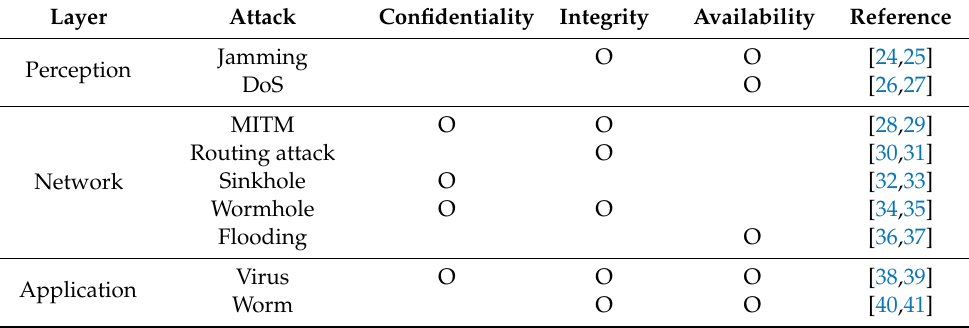
Table 2. Summary of